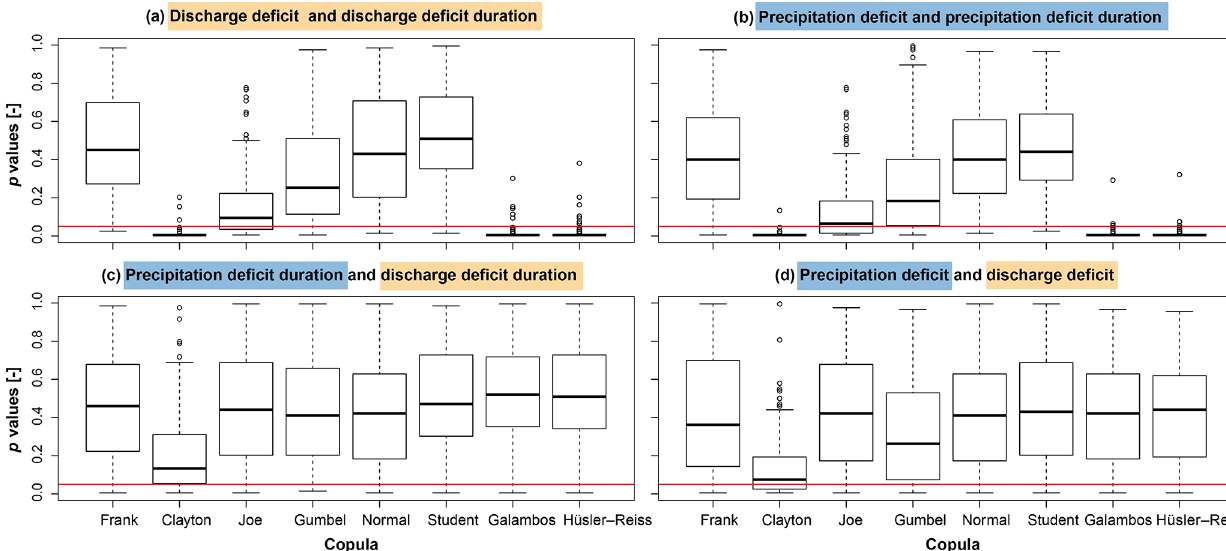
Figure 4. The p values determined by the bootstrap goodness-of-fit test for the eight copulas Frank, Clayton, Joe, Gumbel, Normal, Student’s t , Galambos, and Hüsler–Reiss for the variable pairs (a) discharge deficit and discharge deficit duration, (b) precipitation deficit and precipi- tation deficit duration, (c) precipitation deficit duration and discharge deficit duration, and (d) precipitation deficit and discharge deficit. The red line indicates the 0.05 significance